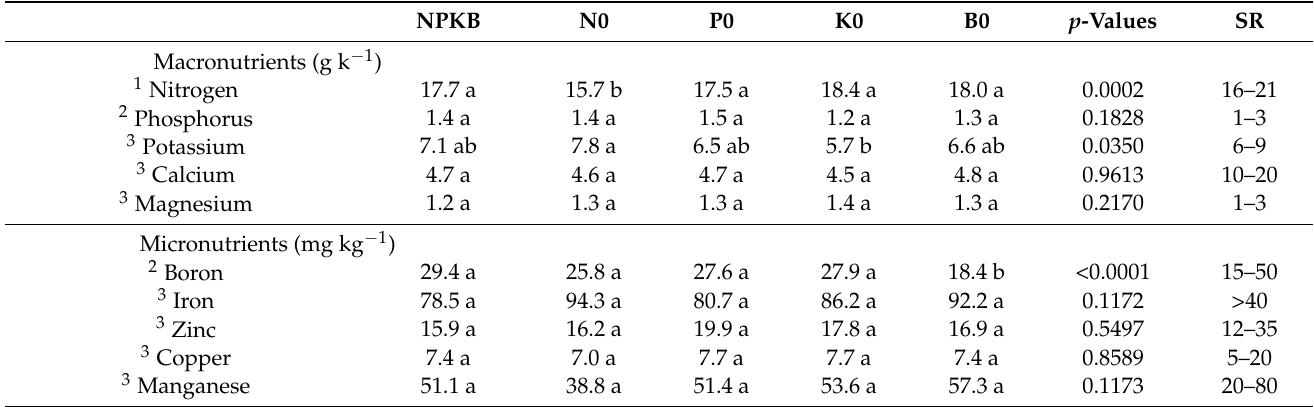
Table 1. Leaf concentration of macro and micronutrients from leaf samples taken at the end of the experiment, in December 2019, as a function of fertilizer treatments [with NPKB (control) and without N (N0), P (P0), K (K0) and B (B0)], and respective sufficiency range (SR) for the resting period of olive, after LQARS [22]. NPKB N0 P0 K0 B0 p -Values